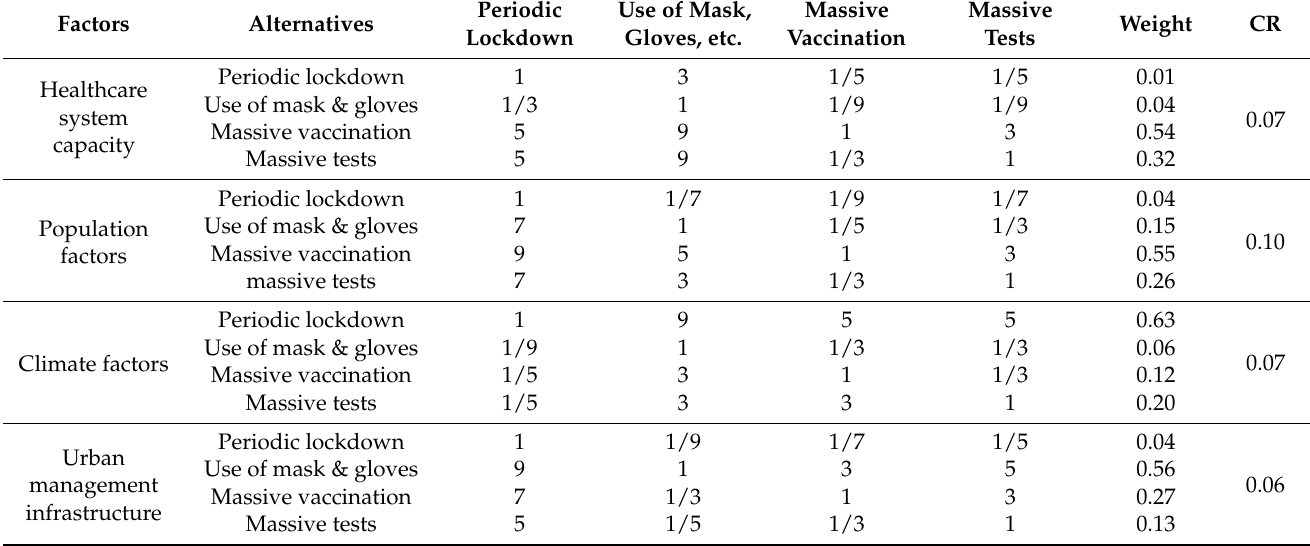
Table 11. Pairwise comparison matrix of alternatives.